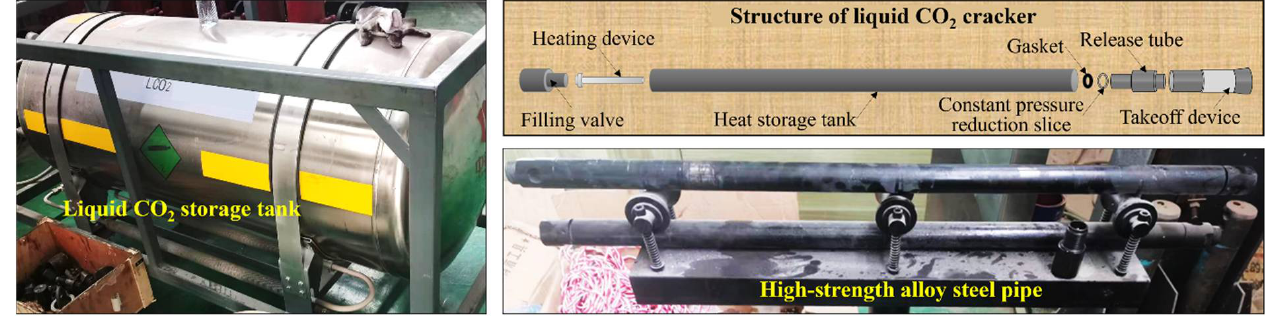
Figure 8. Liquid CO 2 storage tank and cracker.